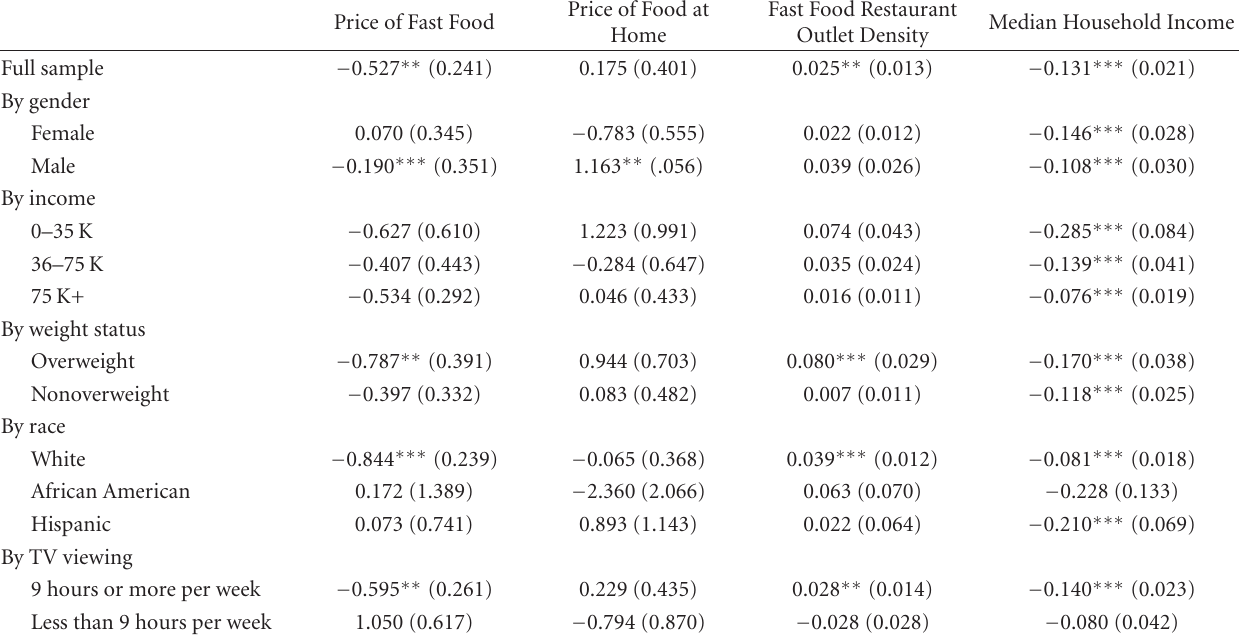
Table 4: Longitudinal regression estimates for individual level random e ff ects model of the determinants of fast food consumption, by sub